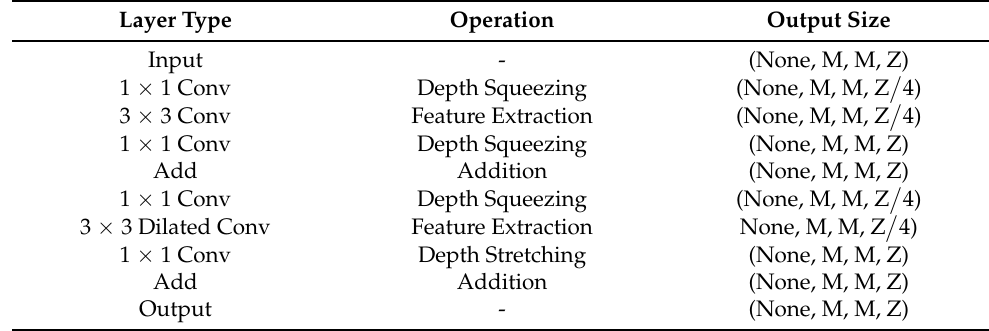
Figure 4. Flow diagram of the proposed deep learning model for hand gesture recognition. Layer wise details along with the sizes of the feature maps are shown in Table 5. Table 4. Architecture details of the proposed Bottleneck within proposed CNN presented in Table 5. Note that ‘M’ is spatial extent and ‘Z’ is depth of the feature maps.